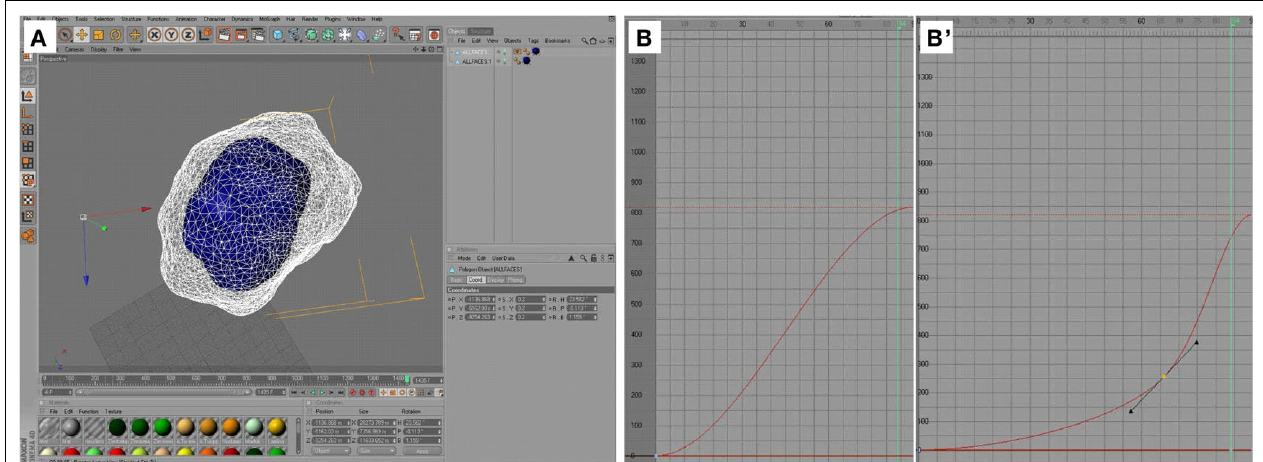
FIGURE 9 | Cinema 4D user interface – animation of the visualization. (A) Interactive mode in Cinema 4D; the center of the adult antennal lobe (A0, white, polygon grid view) is registered semi-automatically with the center of the P16 antennal lobe (blue, polygon surface view). Subsequently, the polygons are adjusted manually to match the shape of the corresponding